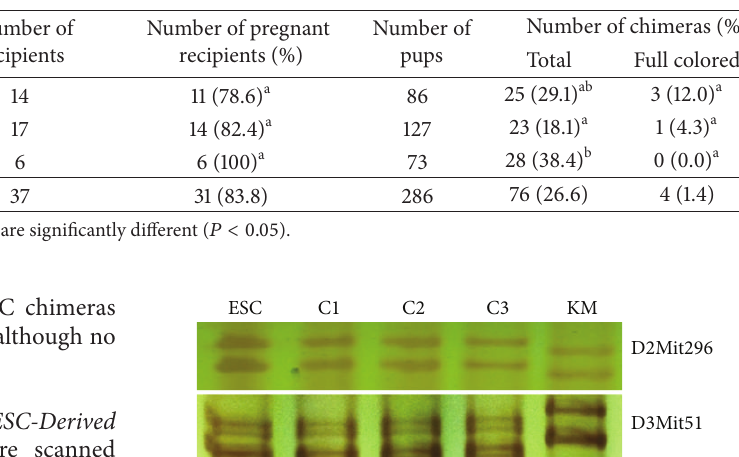
Figure 4: Generation of mouse chimeras with iPSCs iPS. Cells were cultured on day 3 after thawing (a). Chimeric mice generated by injection of 8-cell embryos with iPSCs (b). The black arrow shows the chimeric mouse with the colored coat. Table 2: Generation of chimeric mice with ESCs.